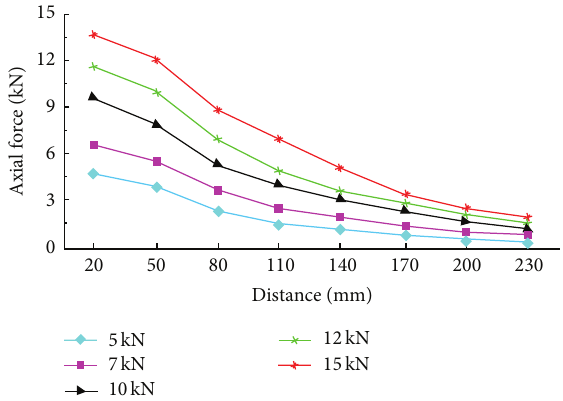
Figure 6: Axial force